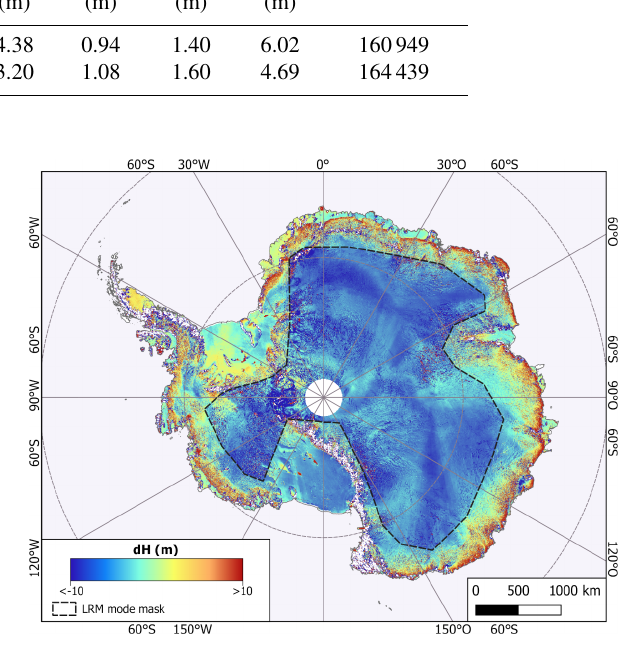
Figure 17. Height difference of TanDEM-X DEM minus CryoSat-2 DEM (rocks: mean ± 2 · SD is masked out in